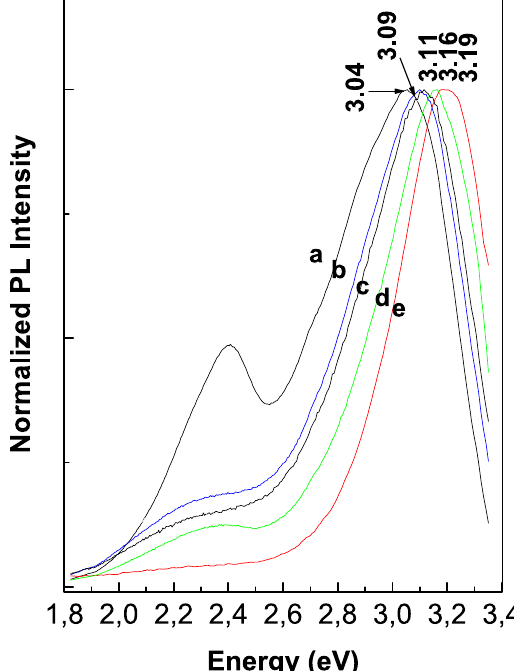
Figure 3. The PL spectra of the powder ( a ) and ANI TR films with thicknesses of 256 ( b ), 192 ( c ), 92 ( d ) and 32 nm ( e